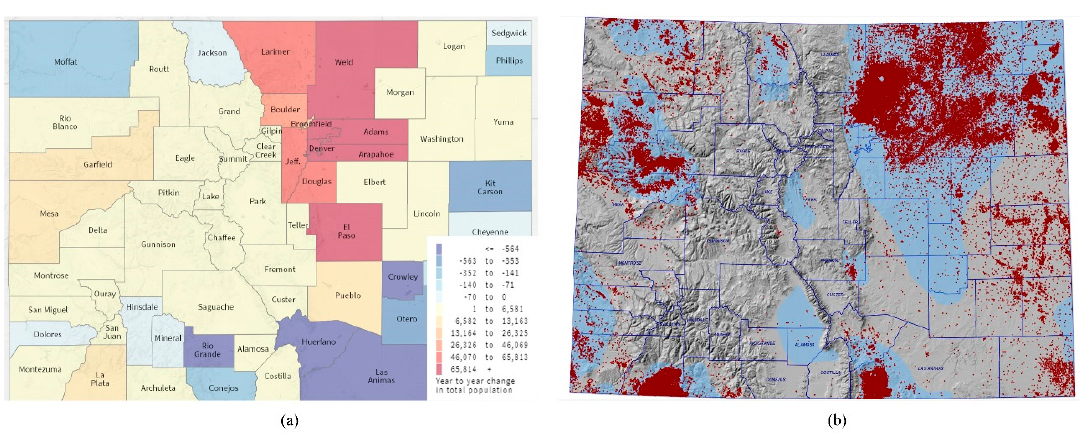
Figure 1. ( a ) Total population growth by county in Colorado (Data Source: Colorado State Demography Office, Department of Local Affairs (2018). Births, Deaths and Migration—Total Population Change 2008–2018. Retrieved from https://demography.dola.colorado.gov/ ComponentsOfChange) ( b ) oil and gas wells (red dots) in Colorado as of June, 2018 (Data Source: Colorado Oil and Gas Conservation Commission).